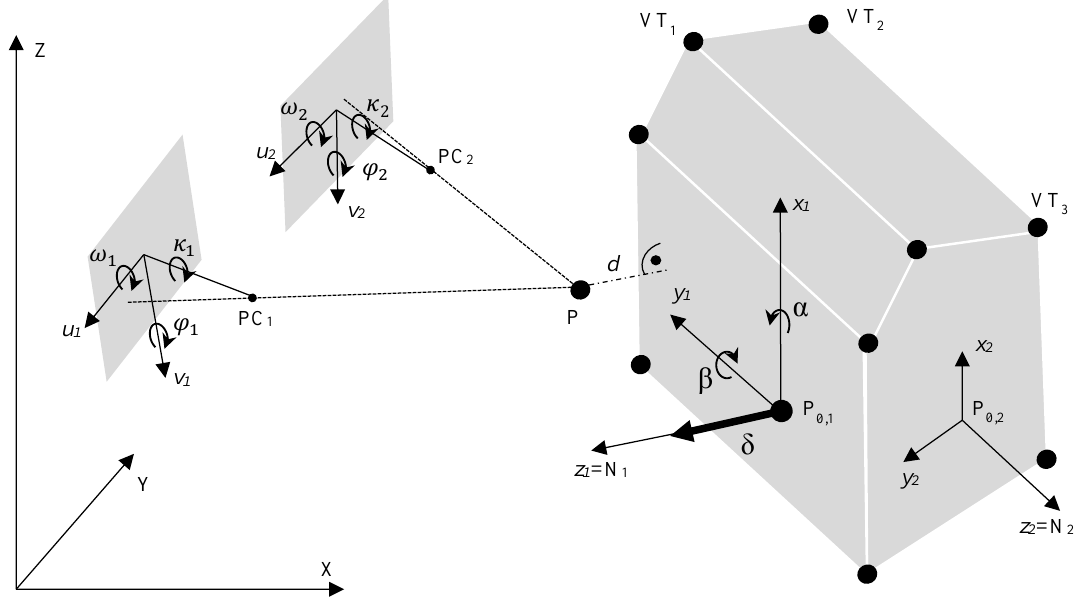
Figure 1: Relevant entities in our scenario (adapted from Unger et al. (2016)): Two poses i of the same camera with image coordinate axes ( u i , v i ), projection centres PC i and three rotation angles (  i ,  i ,  i ) with i  {1,2} represent the multi-view scenario where sensors capture an object point P with world coordinates X, Y, Z. The generalised building model is represented by its vertices VT k with k  {1,2, … } in world coordinates and by the planes they are situated in. Each plane j has a local coordinate system ( x j , y j , z j ) where initially the local z j -axis is the plane normal N j and x j , y j are axes in the plane. The origin of the coordinate system of plane j is 𝑃 0,𝑗 , and each plane coordinate system is rotated relative to the world coordinate system by three angles (  j ,  j ,  j ) that are not shown in the figure. Two angles α, β and a shift δ (bold arrow) along the local z -axis represent the parameterisation of the local plane. The orthogonal distance of an object point P to a corresponding plane of the building model is denoted by d